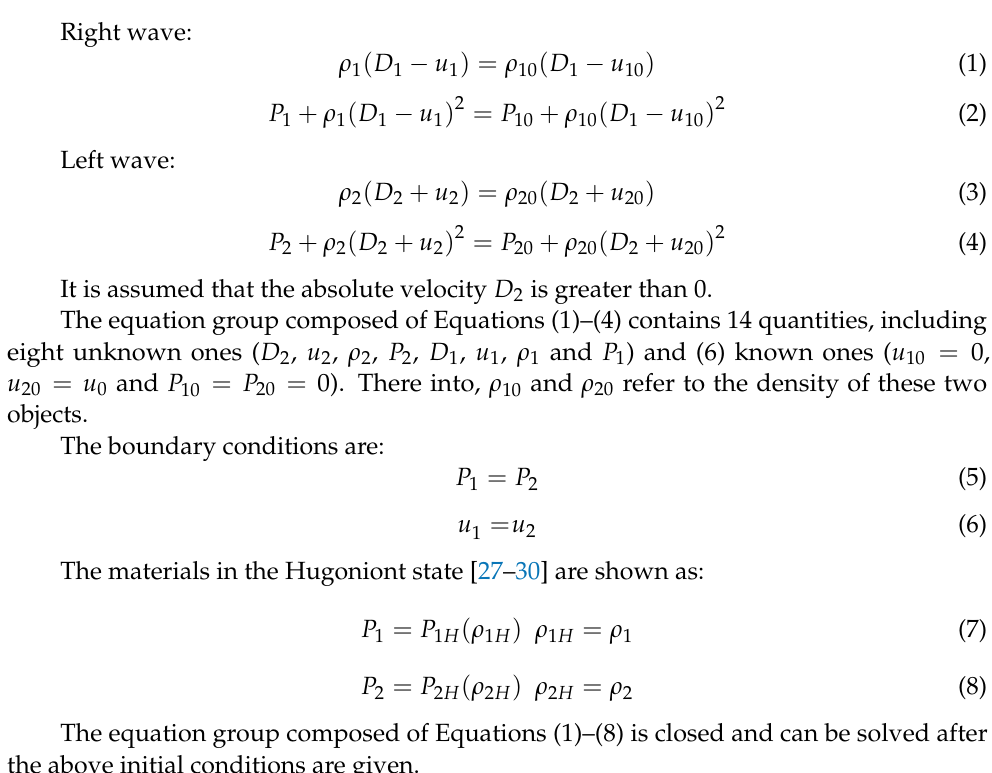
these two objects.